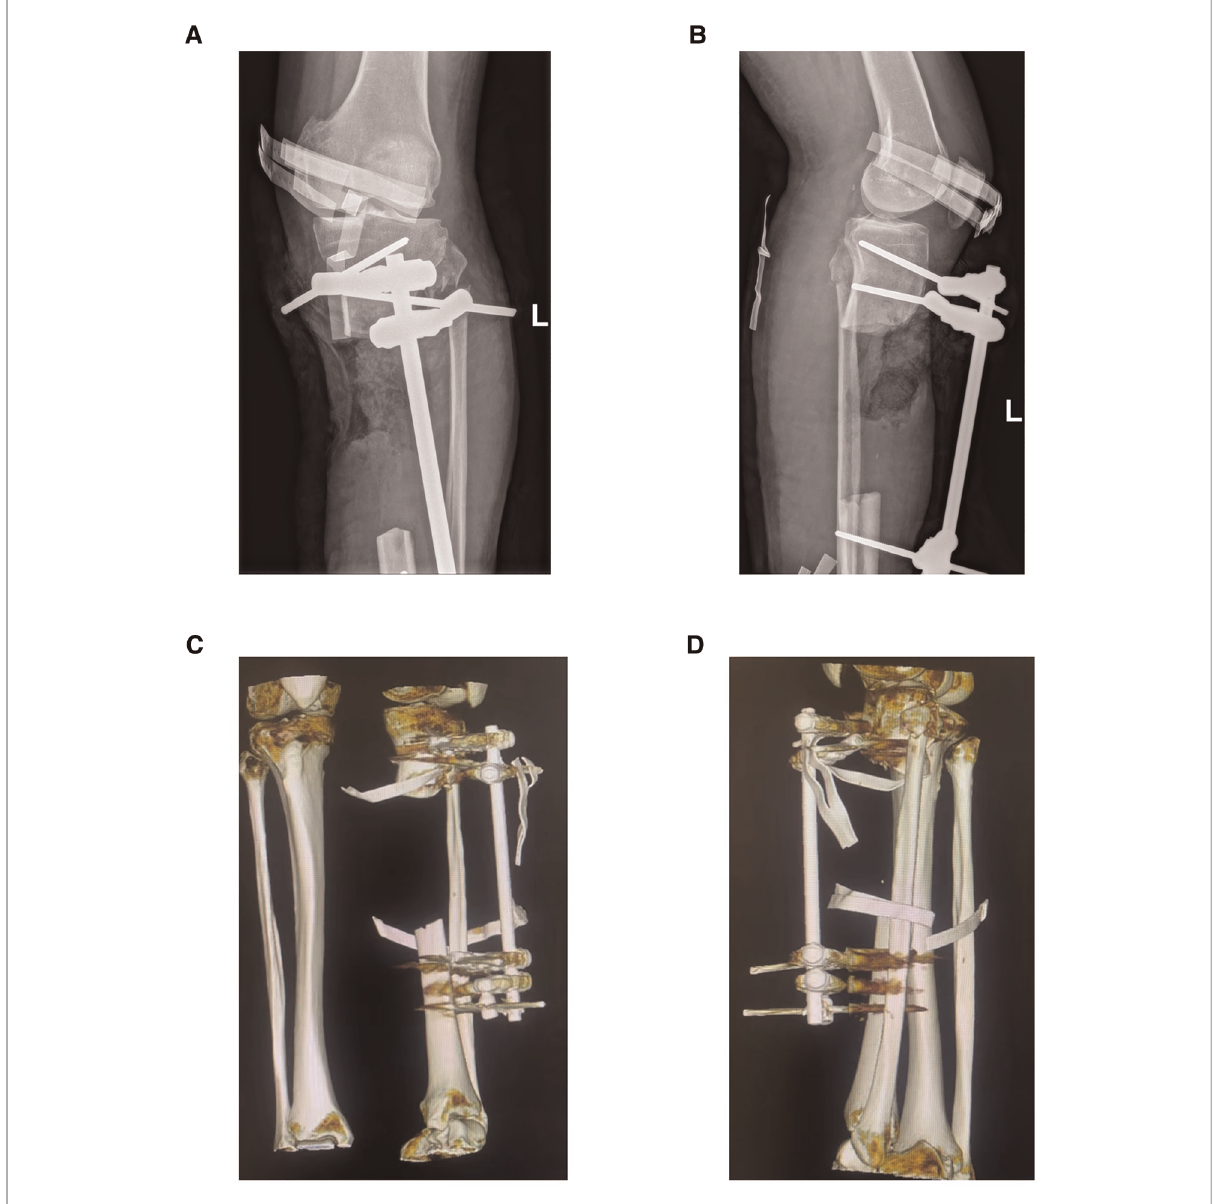
FIGURE 2 Preoperative x-ray and three-dimensional reconstruction of computed tomography (CT) of the left lower limb in case 1. ( A ) Preoperative x-ray on anterior-posterior (AP) view of affected limb in case 1, and there is an approximately 144 mm long bone defect at the proximal tibia. ( B ) Preoperative x-ray on lateral view of affected limb in case 1. ( C , D ) Three-dimensional reconstruction image of case 1 before